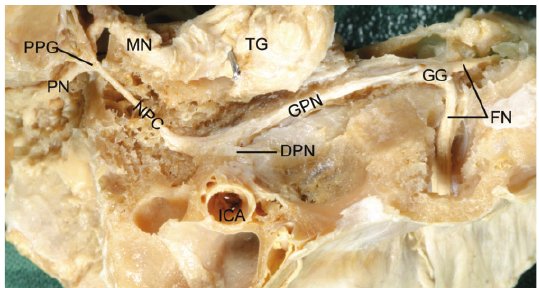
Figure 4: Dissection of the nerve connections between the geniculate and pterygopalatine gangia. PN: palatine nerves, PPG: pterygopalatine ganglion, MN: maxillary nerve, NPC: nerve of pterygoid canal, DPN: deep petrosal nerve, TG: trigeminal ganglion, ICA: internal carotid artery, GPN: greater petrosal nerve, GG: geniculate ganglion, FN: facial